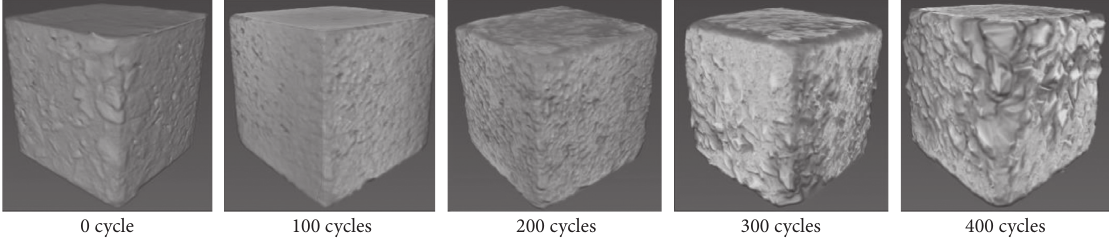
Figure 10: Profile of 0% CaO expansive concrete (C-0) under different freeze-thaw cycles.